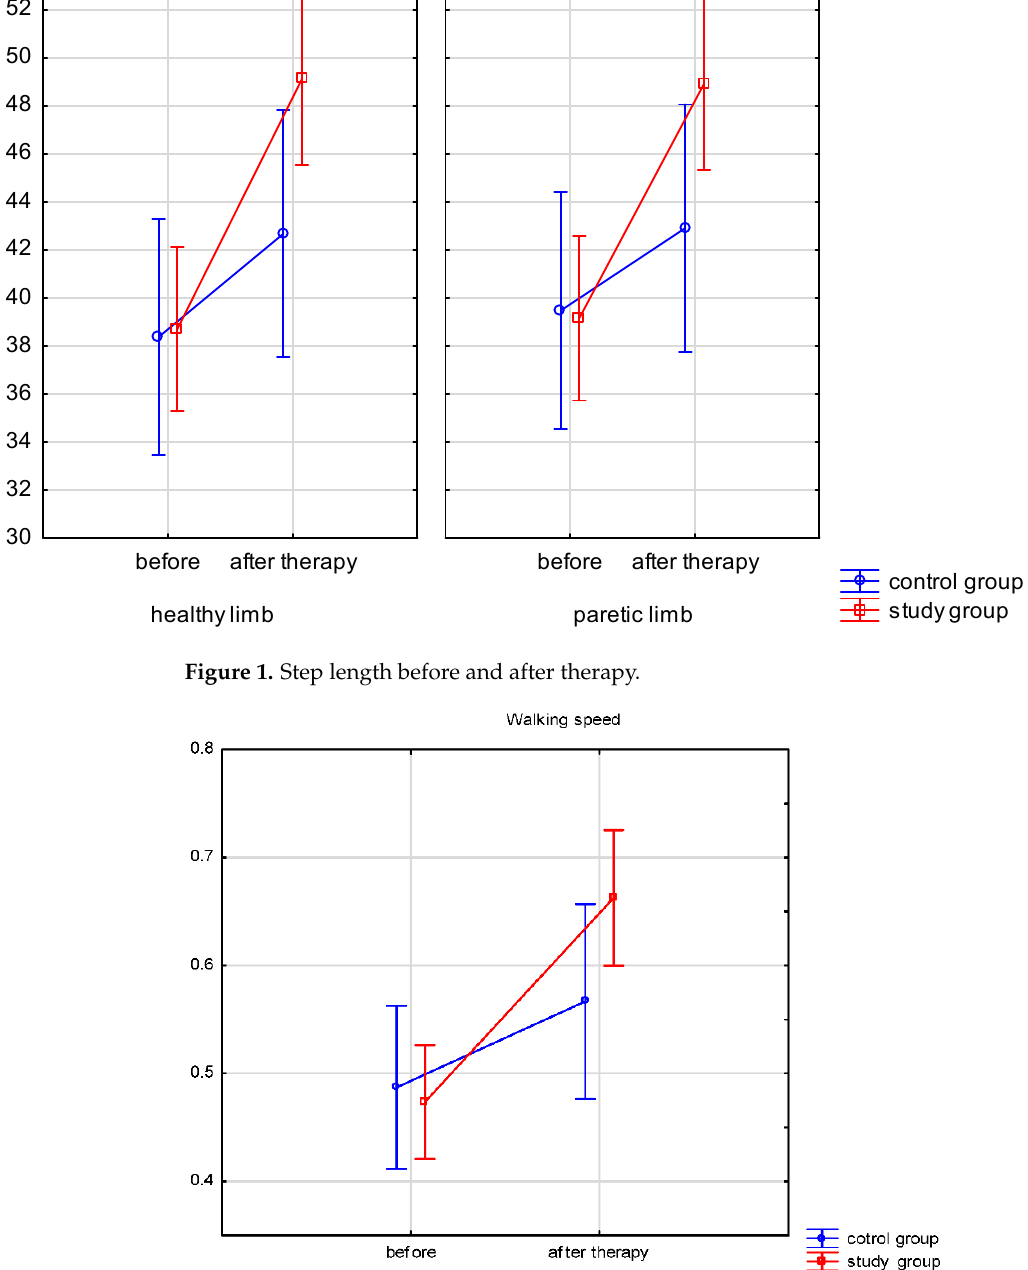
Figure 2. Walking speed before and after therapy.